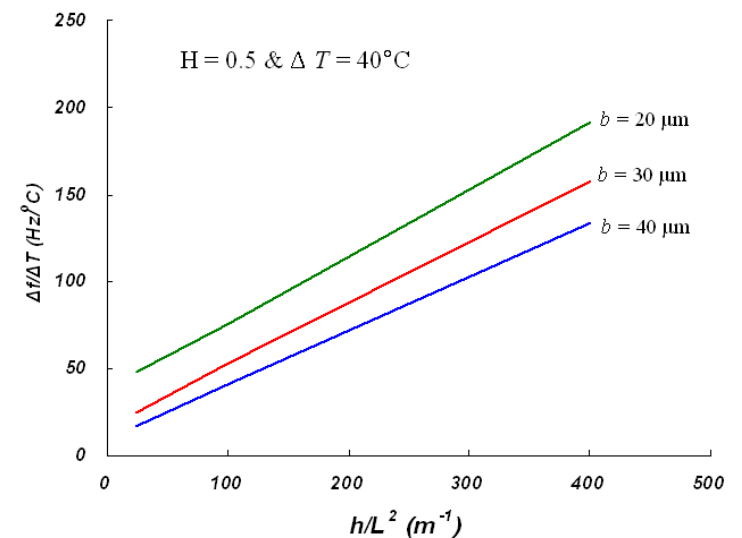
Figure 7. Calculated near-field thermal sensitivity of silicon microcantilevers as functions of h / L 2 for three different widths b = 20, 30, and 40 µm